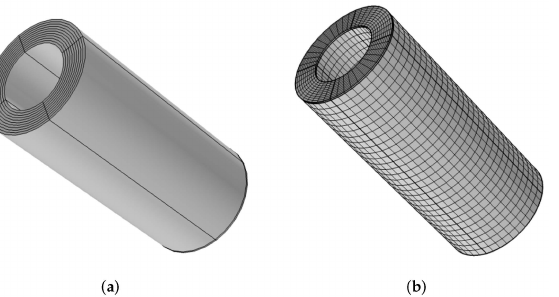
Figure 9. 3D model of the driver, where ( a ) is geometric model and ( b ) is mesh